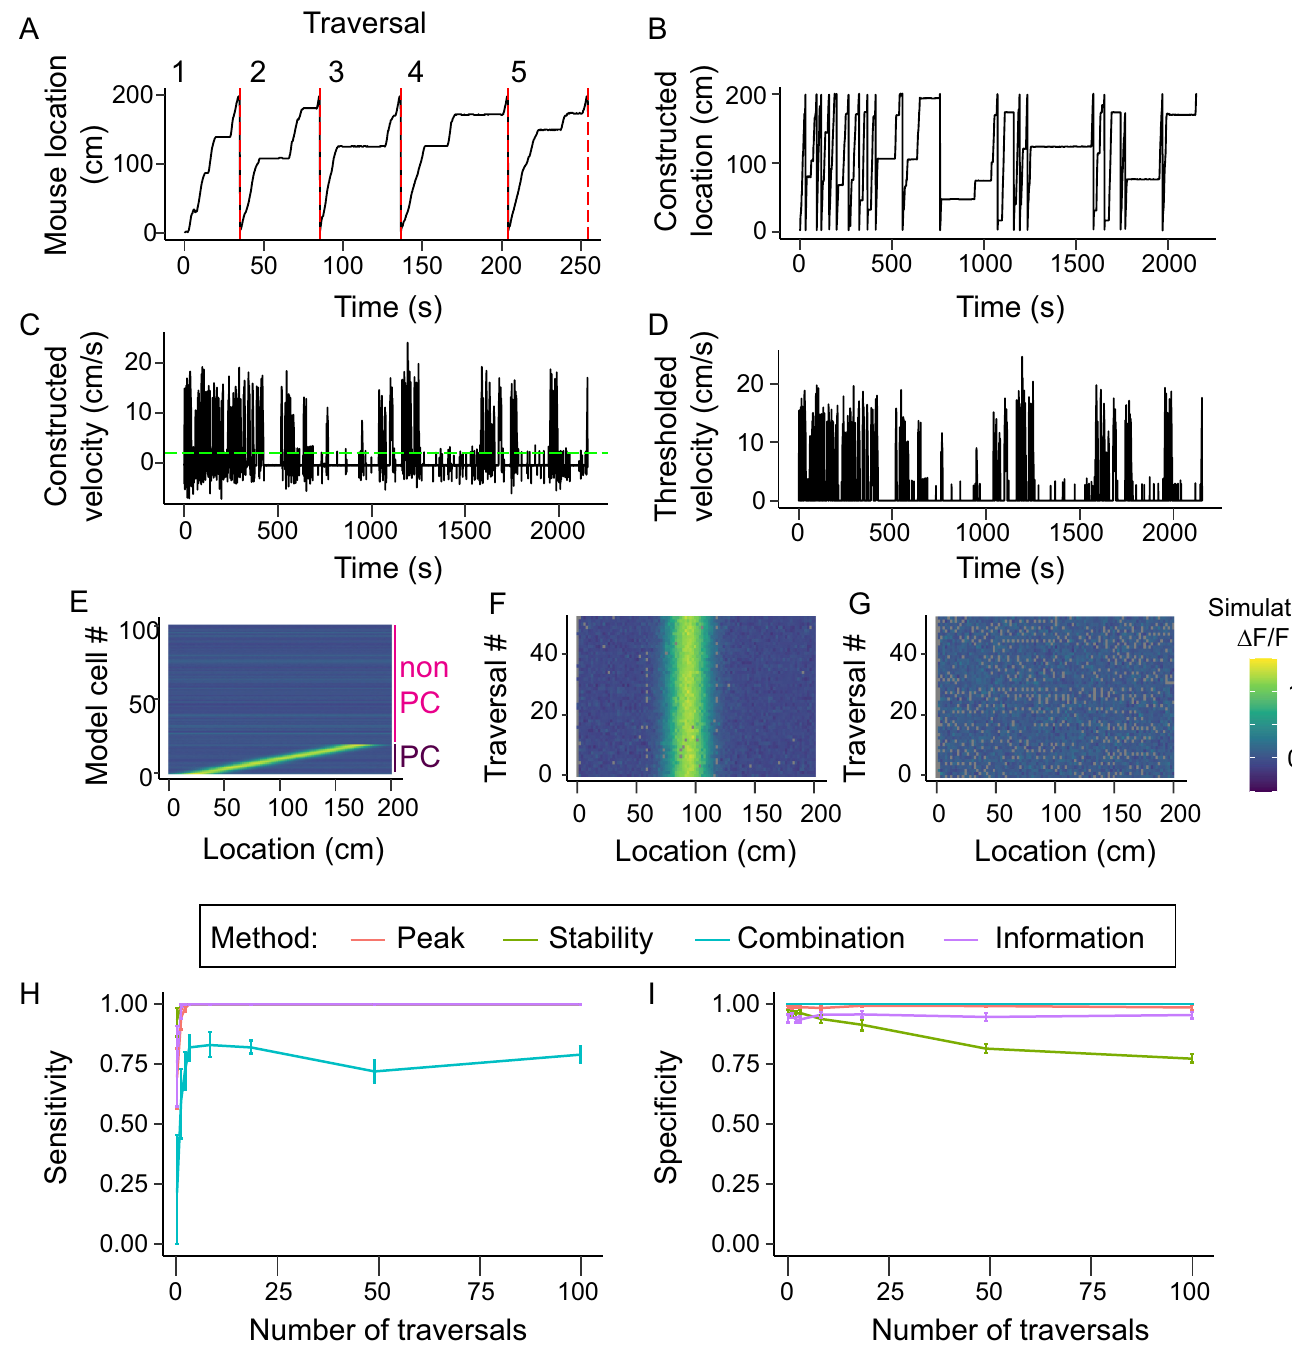
Fig 1. Model locomotion profile generation and effect on methods. (A) Section of a locomotion profile collected in a 200cm long virtual environment. This was cut into individual traversals of the environment (numbered, separated by red dashed lines) (B) locomotion profile generated from 20 randomly selected traversals. (C) Velocity profile of the locomotion profile shown in B. The green dashed line indicates the threshold for detecting running (2 cm/s) (D) Trace in C after thresholding. Time points with below threshold velocity were excluded from further analysis. (E) Fluorescence maps of 20 model place cells (cells 1–20) and 80 non- place cells (cells 81–100). (F) Activity over location of a single model place cell over 50 traversals. (G) Activity over location of a single non-place cell over 50 traversals. Grey points in F and G are missing data caused by the mouse across this location between acquisition of two frames. (H) The sensitivity of each method as a function of the number of traversals included in the locomotion trace. (I) The specificity of each method as a function of number of traversals. Lines in (H) and (I) show means over 10 randomly generated data sets. Error bars represent 95% confidence intervals.